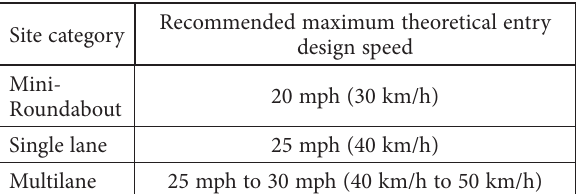
Table 2. Recommended maximum entry design speeds (Rodegerdts et al.,